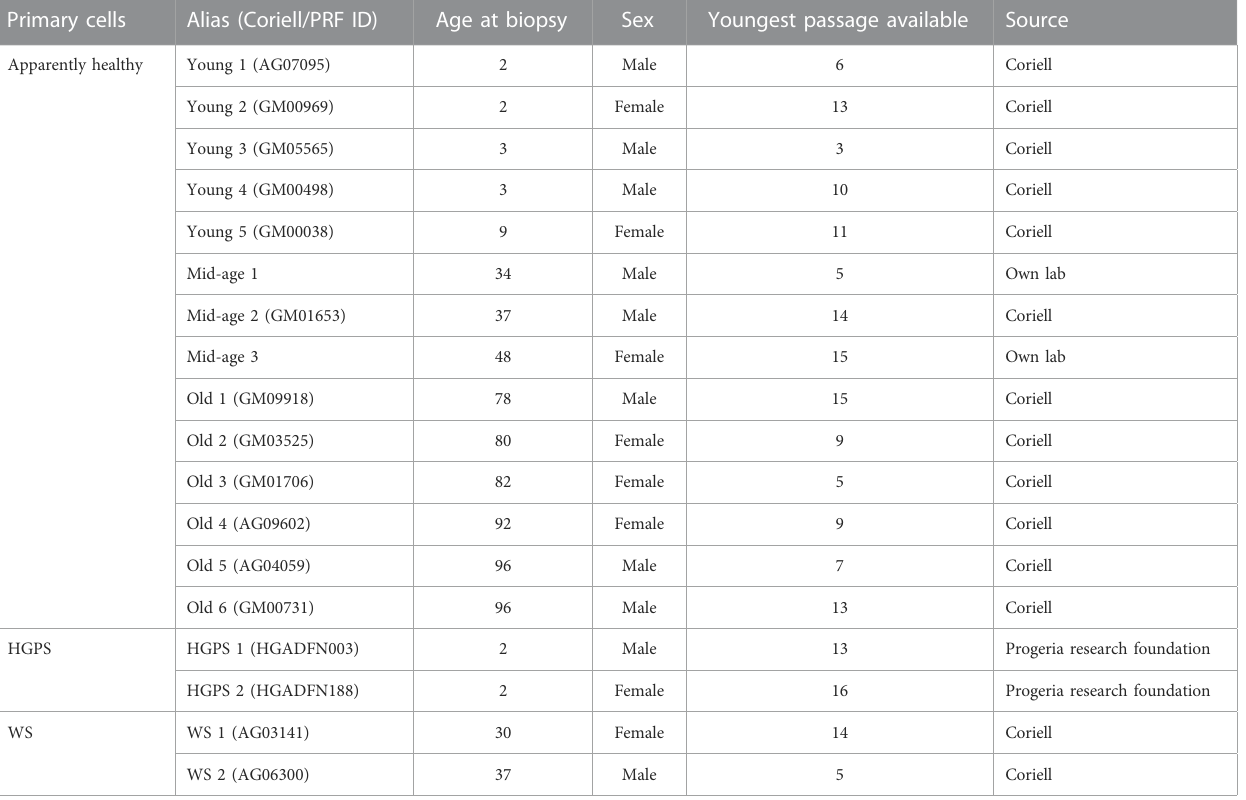
TABLE 1 Characteristics of human fi broblasts used in this study. Primary cells Alias (Coriell/PRF ID) Age at biopsy Sex Youngest passage